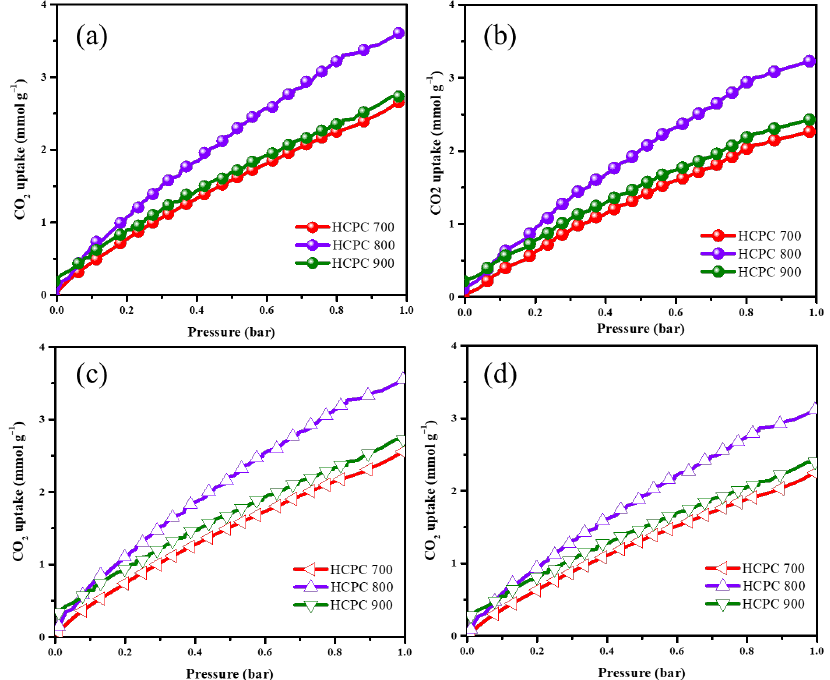
Figure 8. CO 2 adsorption ( a , b ) and desorption ( c , d ) isotherms for the carbon spheres measured at 25 °C and 0 °C.